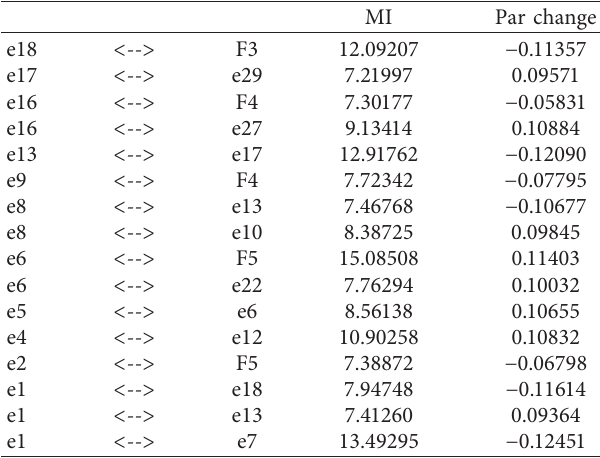
Table 7: Partial modified index (MI) of the theoretical model of internal factors (only MI ≥ 6).